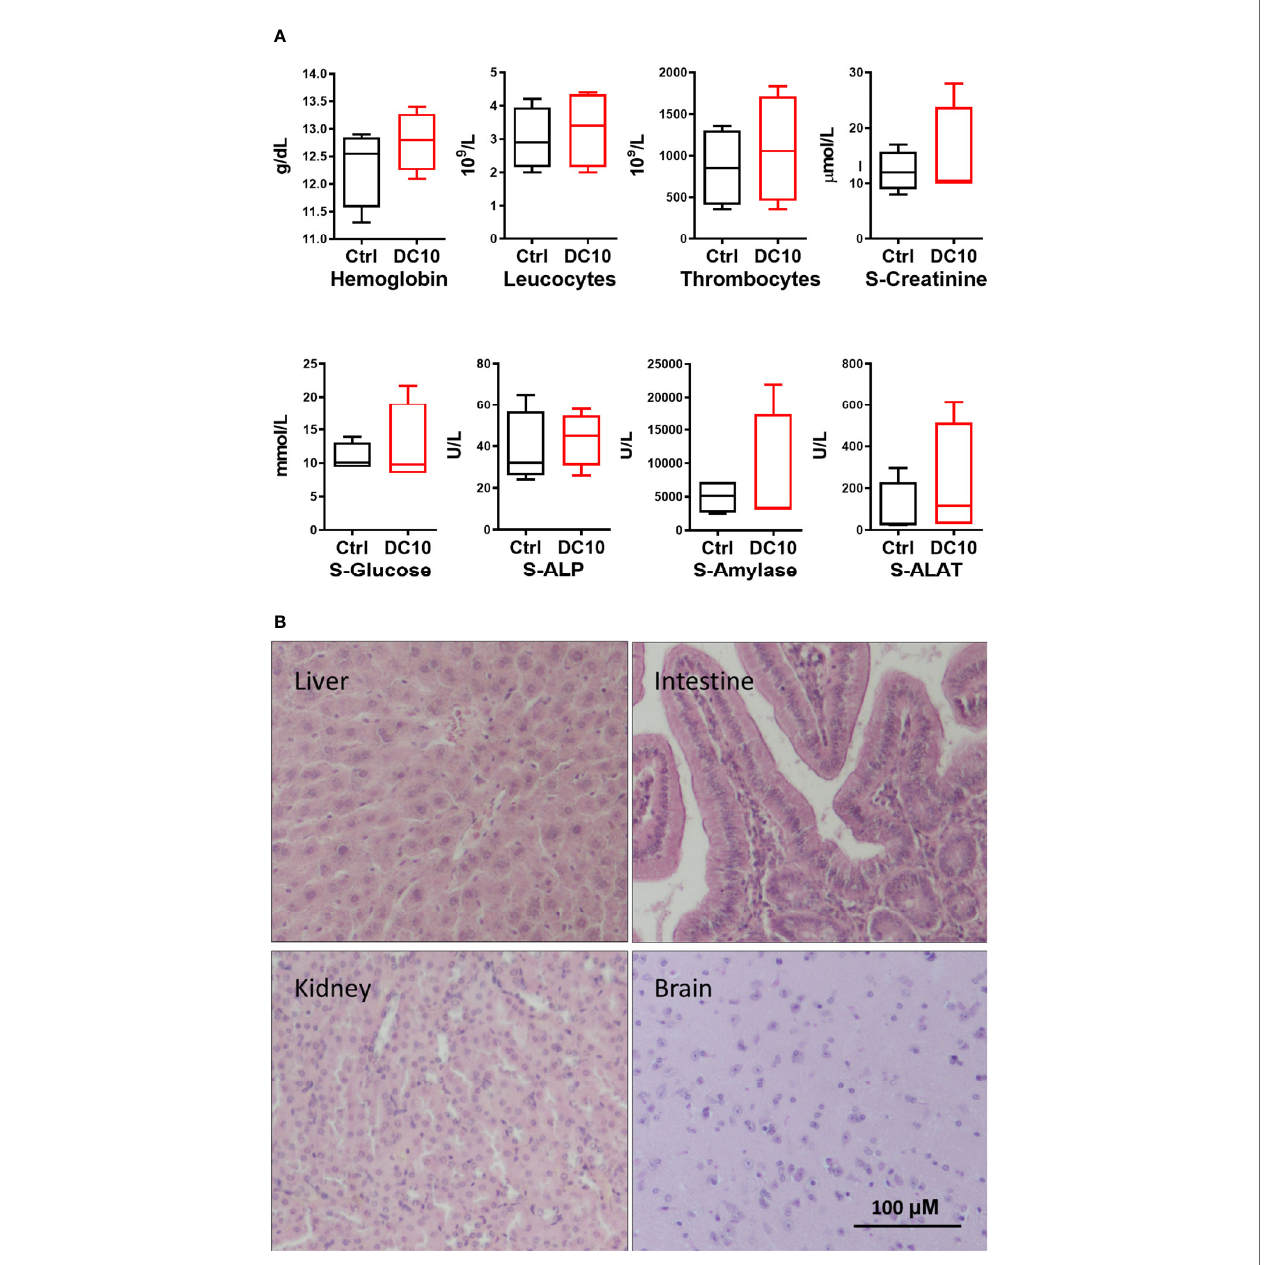
FIGURE 5 | Toxicology screening of DC10 in vivo . (A) Blood cells and biochemical analysis of samples from animals receiving DC10 (red) or controls receiving vehicle (black). S-ALP, Serum alkaline phosphatase; S-ALAT, Alanine transaminase. (B) H/E-stained sections of organs harvested from mice 10 days post DC10- treatment. 40x, Scale bar: 100